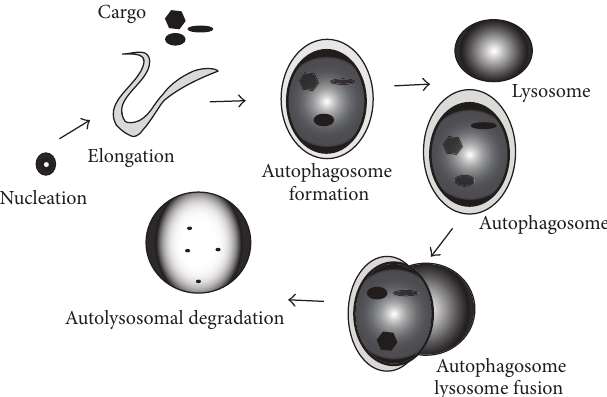
Figure 1: Autophagy pathway. Autophagy is a membrane-dependent pathway that involves a defined series of steps. The pathway is initiated by the autophagosome nucleation step (formation of a preautophagosomal structure leading to an isolation membrane or phagophore). This is followed by autophagosome membrane elongation. The next steps involve the formation of the mature autophagosome, which engulphs cytosolorspecificsubstratessuchasmitochondriaorubiquitinatedproteins. Subsequently,theautophagosomecontainingitscargofuseswith the lysosome. In the autolysosome, the autophagosomal cargoes are digested by lysosomal hydrolases and the contents released for metabolic